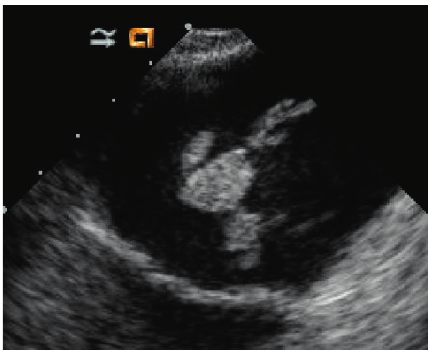
Figure 1: TEE image showing a 3.6 cm pedunculated mass within the left atrium.